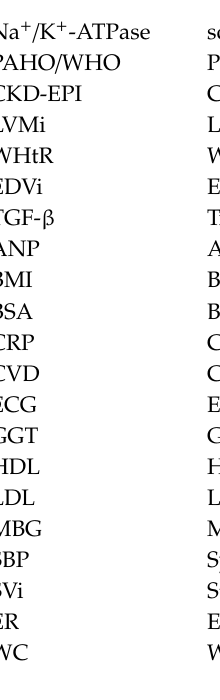
Table S1: Characteristics of 275 participants followed over 4.5 years compared with 927 participants from the African-PREDICT cohort. Table S2A: Characteristics of 215 participants with a BMI < 30 kg / m 2 (non-obese) followed over 4.5 years. Table S2B: Characteristics of 60 participants with a BMI ≥ 30 kg / m 2 (obese) followed over 4.5 years. Table S3: Multiple regression analyses with follow-up LVMi and percentage change in LVMi as dependent variables and baseline MBG excretion as the main independent variable. Table S4: Backward stepwise regression model with obesity defined according to BMI, WC, and WHtR criteria. Table S5. Backward stepwise multiple regression analyses with follow-up LVMi and percentage change in LVMi as dependent variables, and baseline estimated NaCl intake as the main independent variable. Table S6: Estradiol levels of men and women in the African-PREDICT study. Table S7: Pearson correlations between the percentage change in LVMi and estradiol in men and